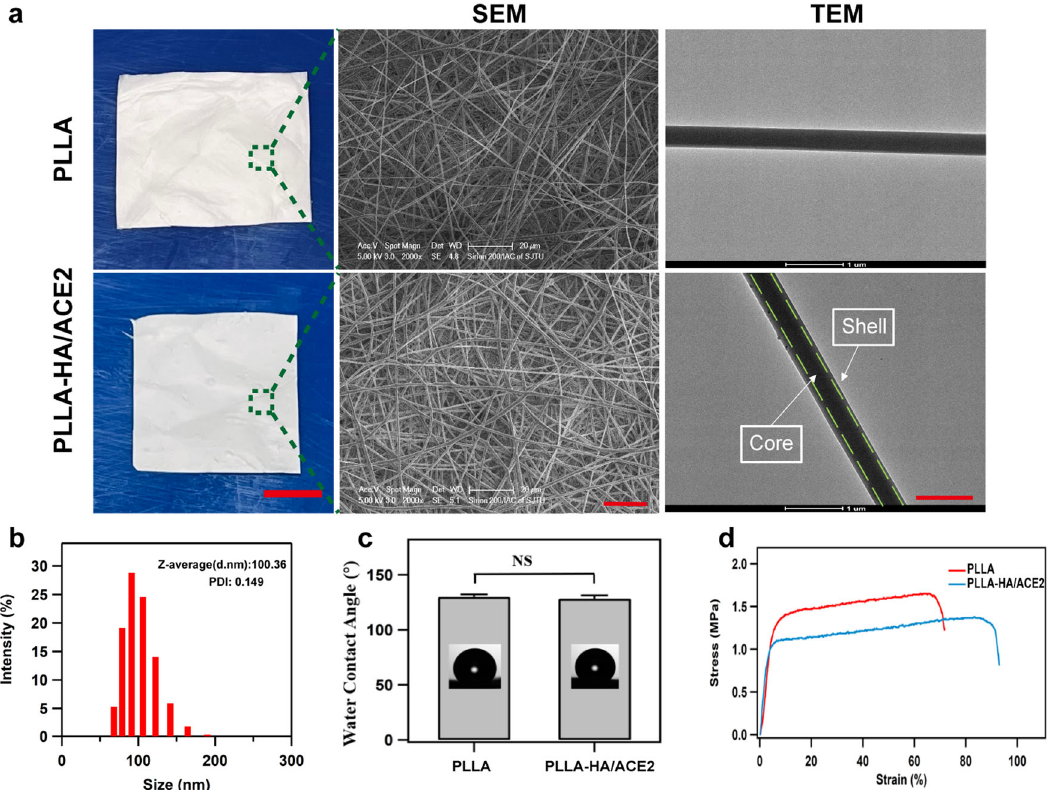
Fig. 2 Characterization of the rhACE2 patch. The general view, SEM and TEM micrographs demonstrating the core-shell structure ( a ), dynamic light scattering ( b ), water contact angle ( c ) and stress-strain curve ( d ) from PLLA-HA/ACE2 electrospun nano fi bers. Scale bars represent 1 cm in general view, 20 μ m in SEM and 1 μ m in